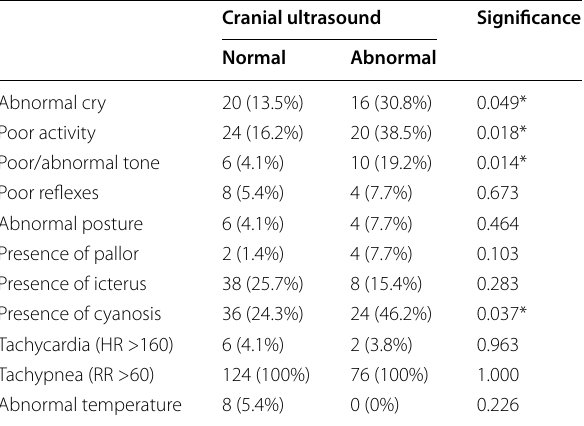
Table 5 Incidence of abnormal clinical and their association with CUS